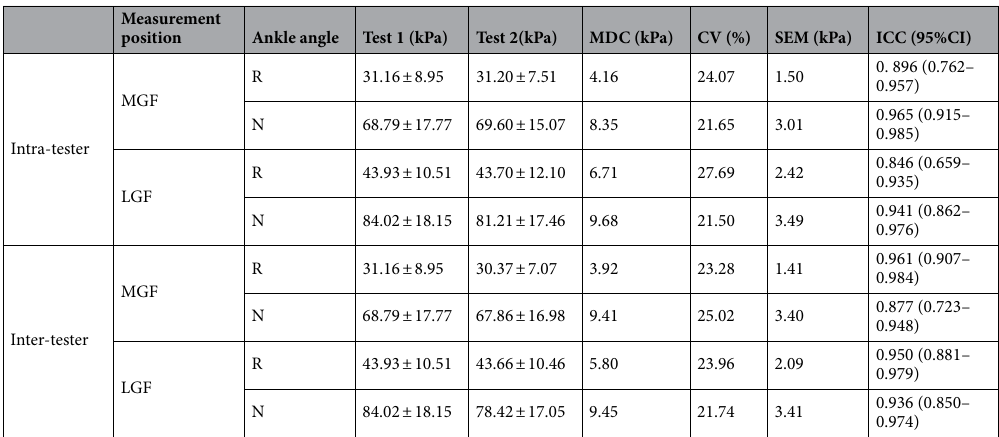
Table 2. Intra- and inter-tester reliabilities of USWE for mean shear modulus of MGF and LGF. R Relaxing position, N Neutral position. LGF Lateral gastrocnemius fascia, MGF Medial gastrocnemius fascia. MDC Minimal detectable change, CV Coefficient of variation, SEM Standard error in measurement, ICC Intra-class correlation